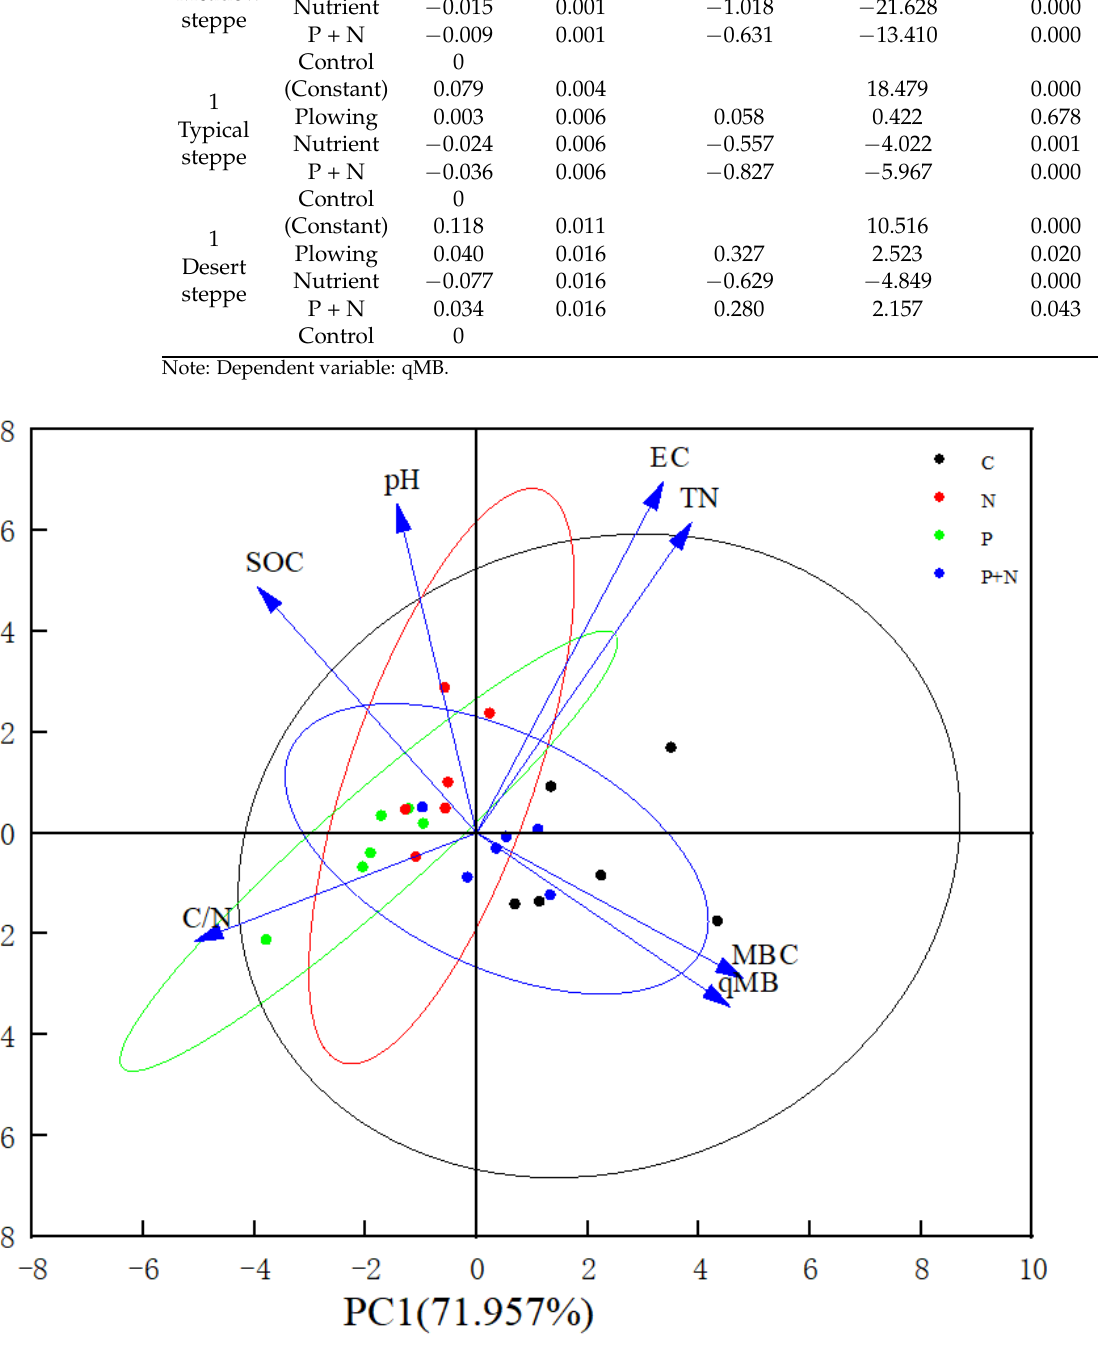
Figure 4. Principal component analysis of meadow steppe. pH: Soil pH; EC: soil electrical conduc- tivity; SOC: soil organic carbon; TN: soil total nitrogen; C/N: soil C/N ratio; MBC: soil microbial biomass carbon; qMB: soil microbial entropy. The same as below.